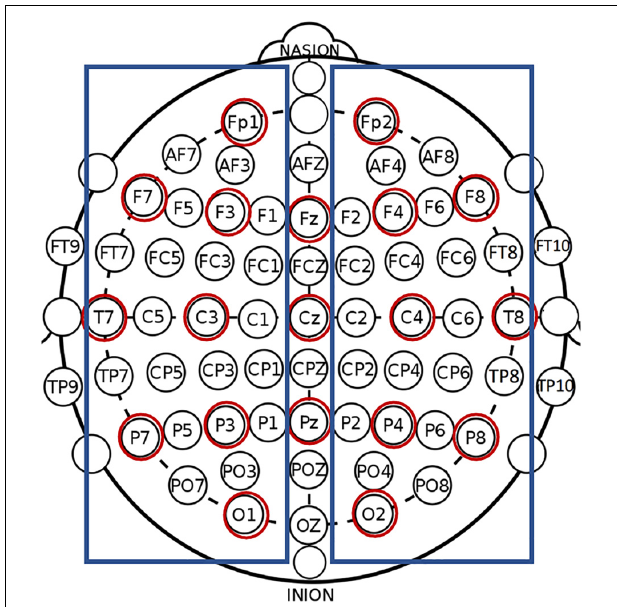
FIGURE 1 | All labeled electrodes were included in the whole brain montage. Red circles show electrodes included the clinical (10–20 montage), and blue boxes show electrodes included in the left and right hemisphere